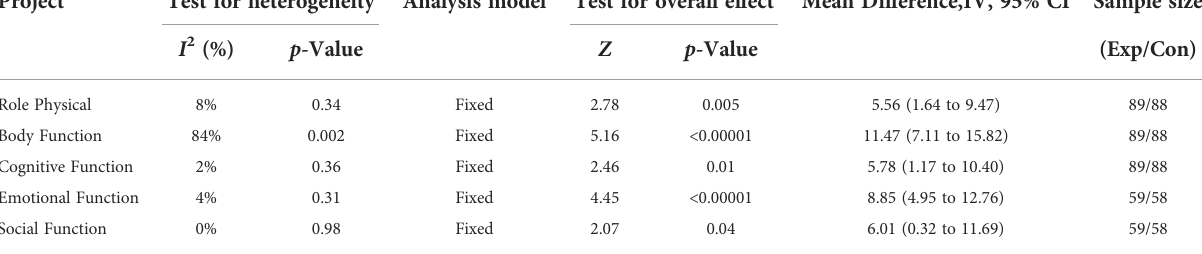
TABLE 3 Patient self-rated functional scale *